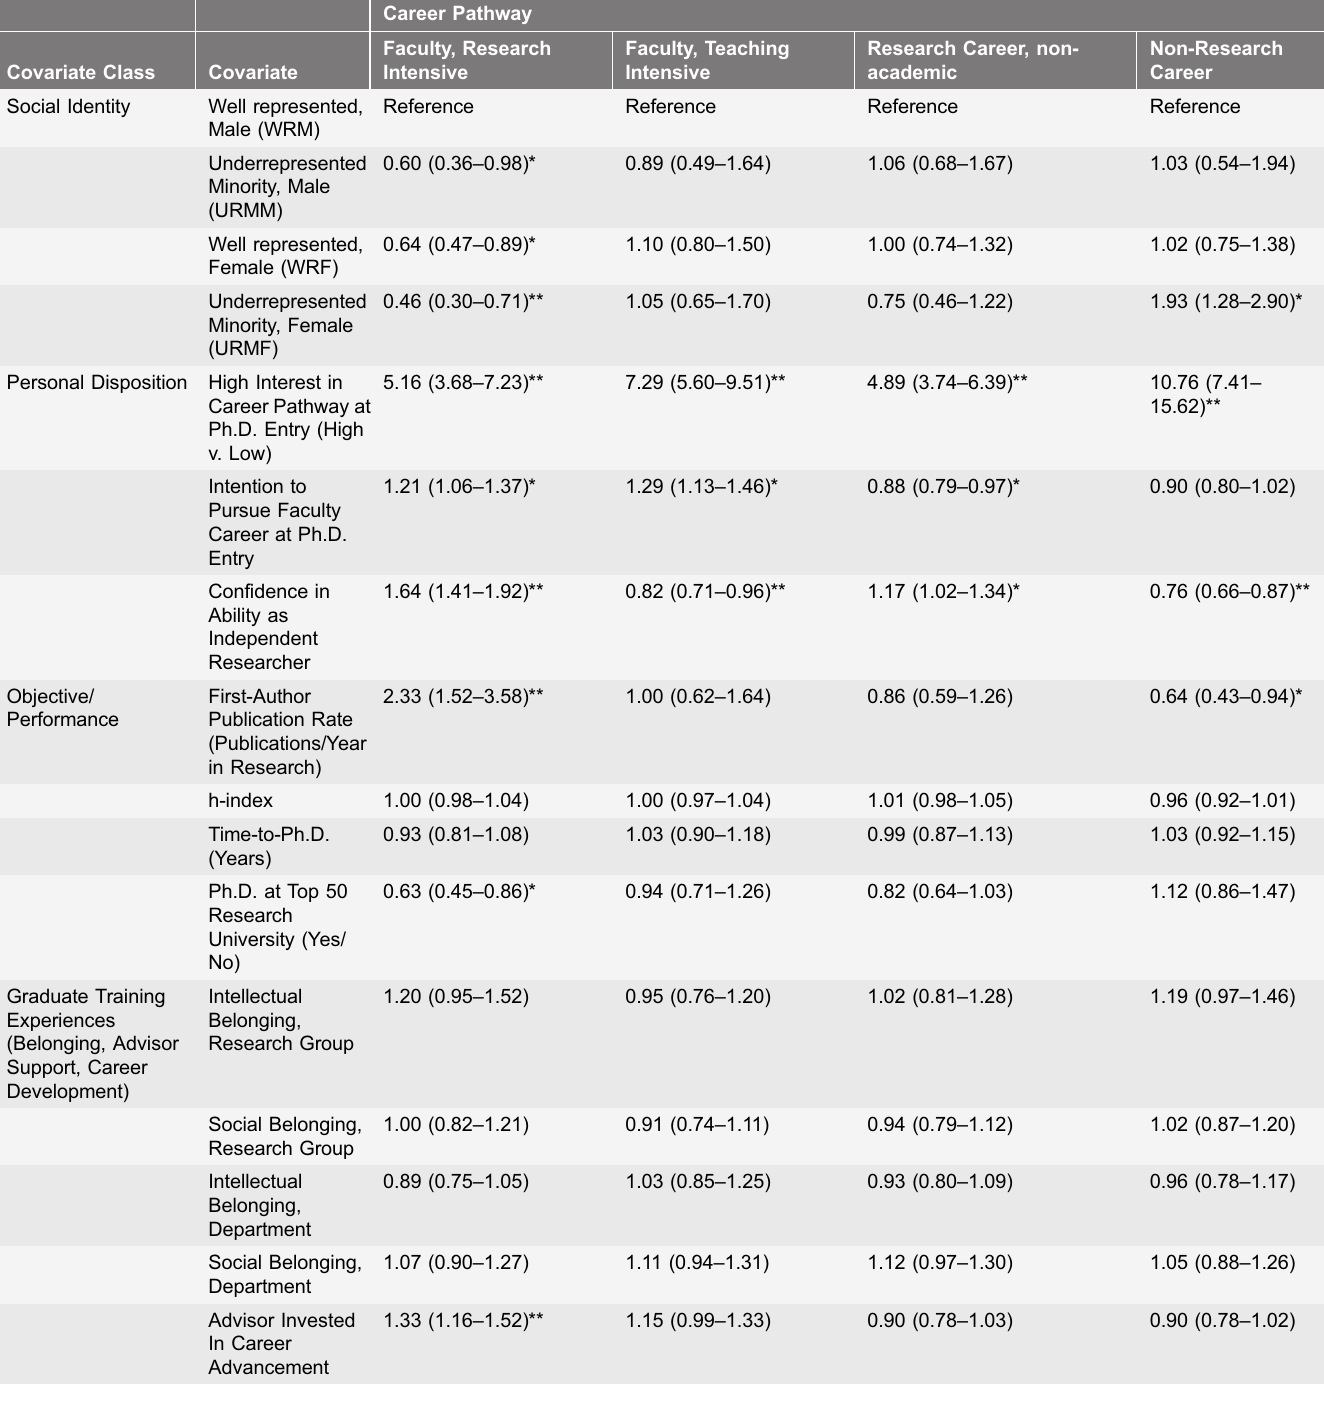
Table 1. Multiple Logistic Regression of Factors Associated with Reporting High Interest in Each Career Pathway at Ph.D.